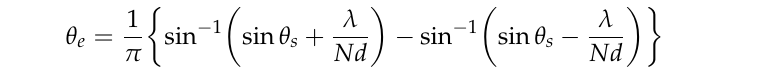
Figure 3. The influence of the number of array elements: ( a ) directivity and ( b ) the main lobe width. According to Expression (8), its analytical result can be derived as: θ = sin − 1 ( sin θ s − m λ / Nd ) . The two angles corresponding to m = 1 and m = − 1 represent the left and right zeros of the main lobe ( θ s > 0), and then, the main lobe width can be normalized